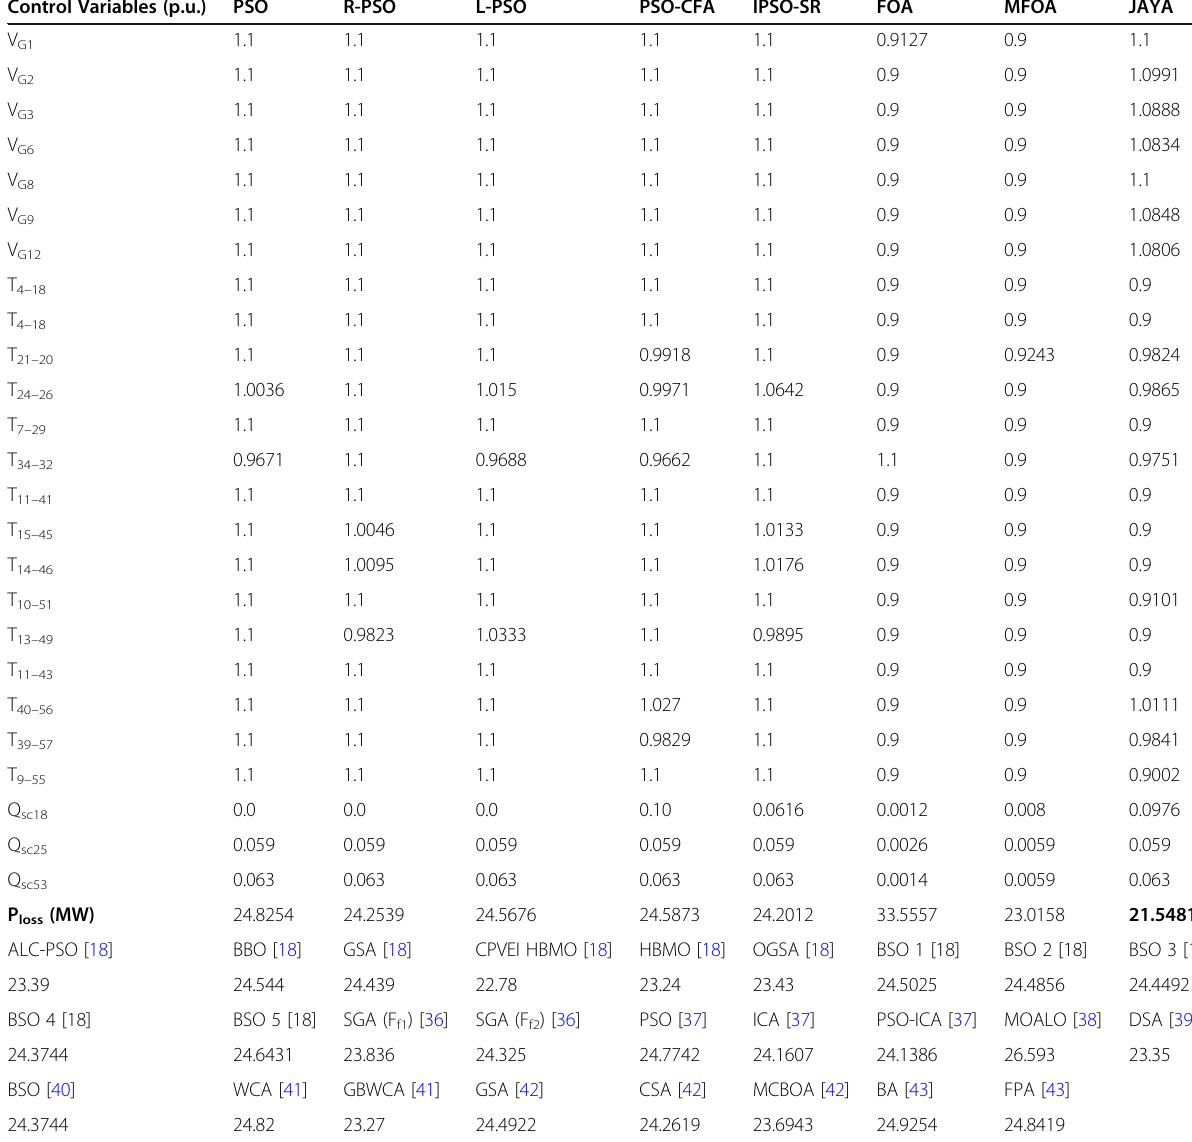
Table 8 Simulation results on the IEEE 57 bus system using different algorithms without DG Control Variables